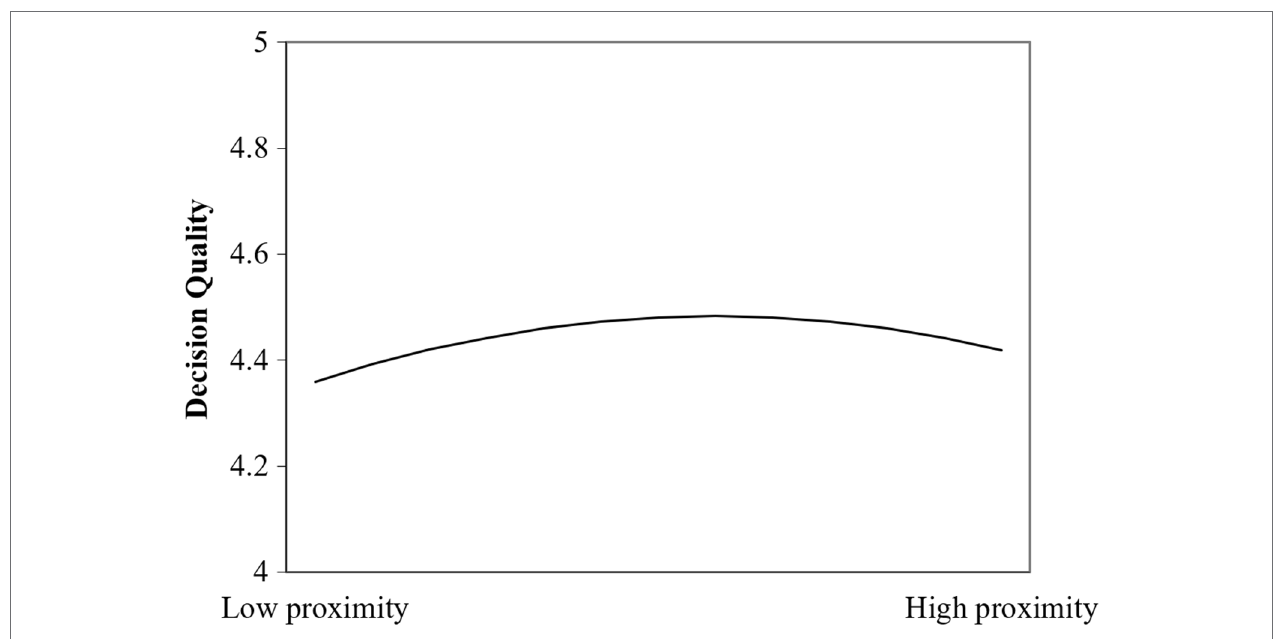
FIGURE 1 | Cognitive proximity and decision